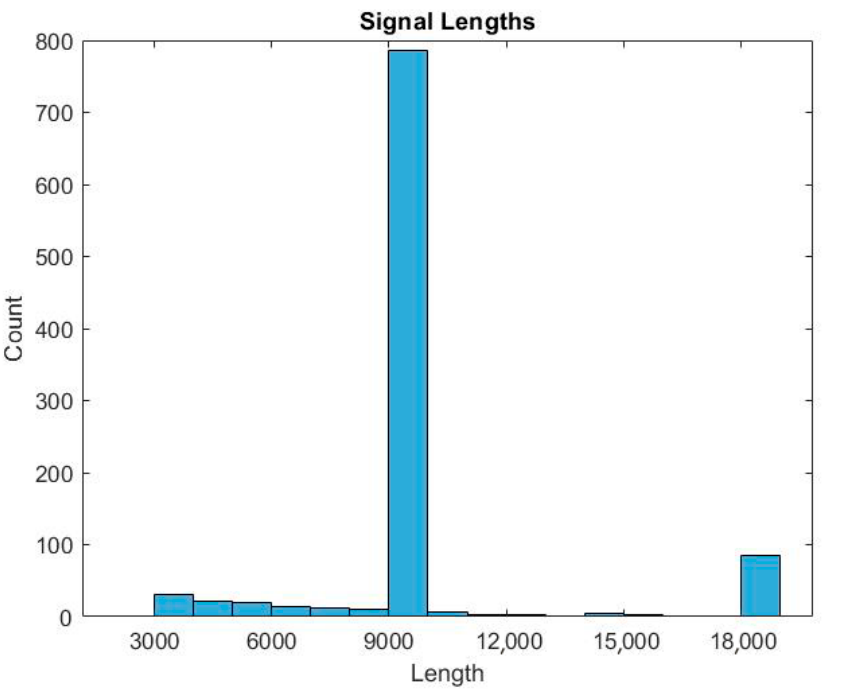
Figure 7. Histogram of the ratio of the number of samples to the number of signals.